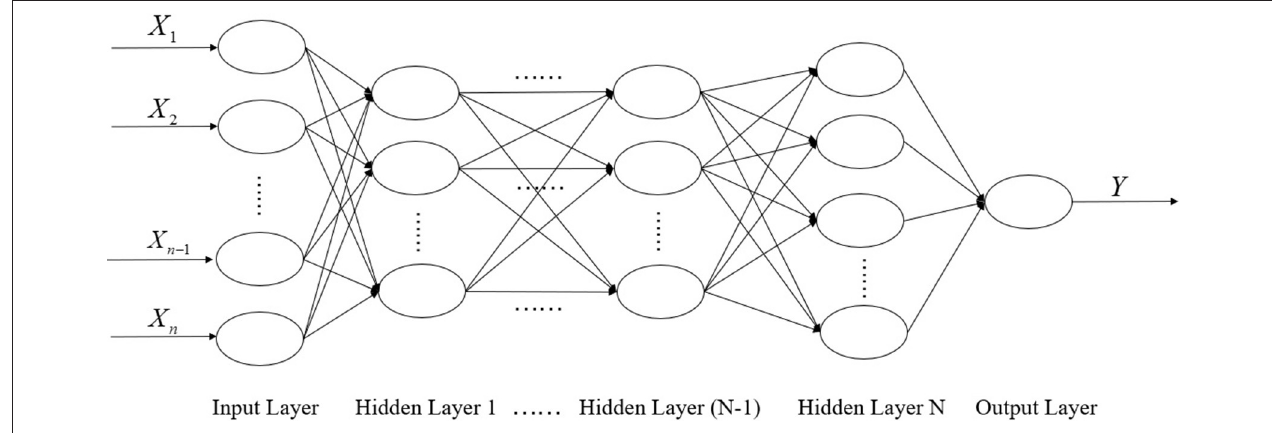
FIGURE 1 | The structure of